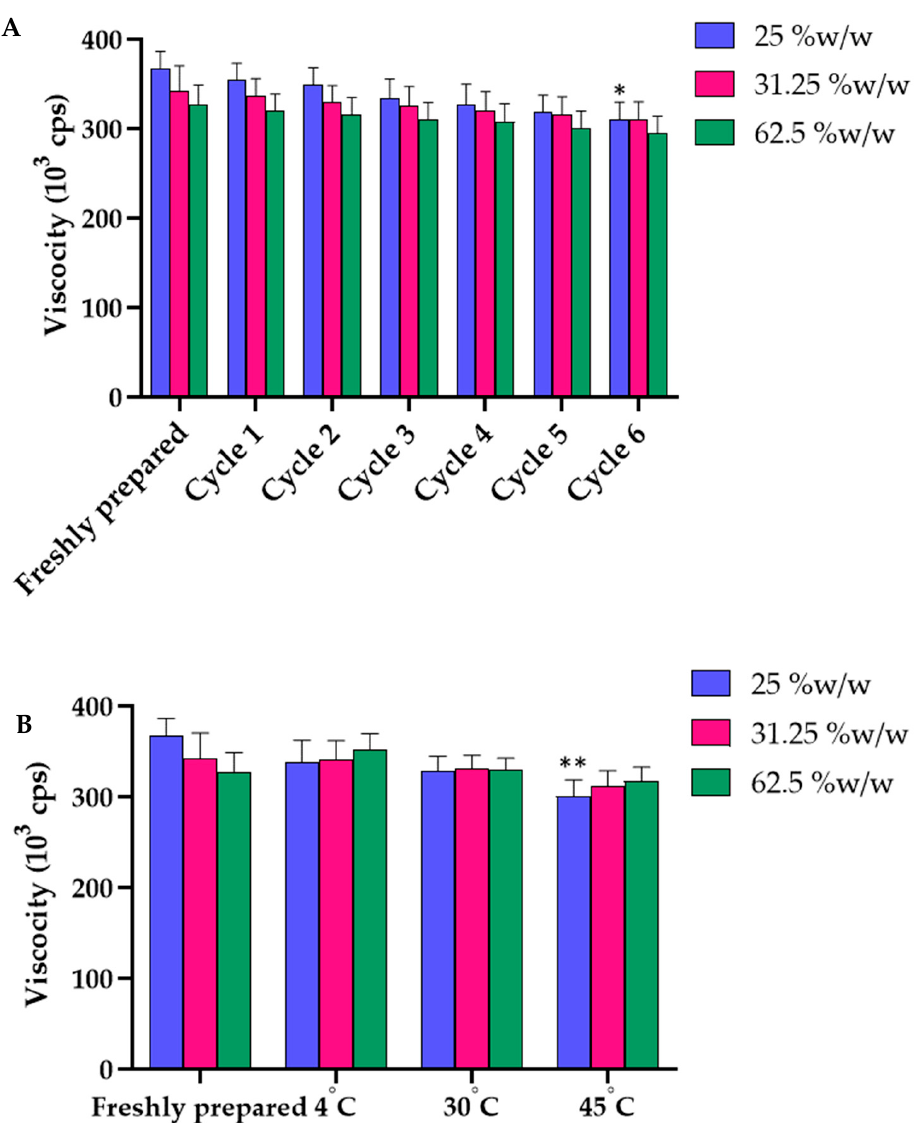
Figure 9. ( A ) Effects of six heating–cooling cycles on the viscosity of gel containing 25, 31.25 and 62.5% w/w of B. flabellifer male flower ethanolic extract. ( B ) Effect of temperature on the viscosity of gel containing 25, 31.25 and 62.5% w/w of B. flabellifer male flower ethanolic extract after storage at 4, 30, and 45 ◦ C for 1 month. * Indicated p < 0.05 and ** indicated p <